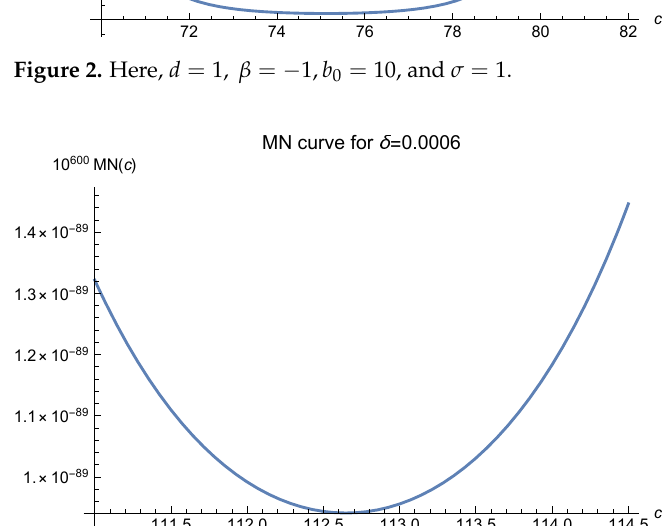
Figure 2. Here, d = 1, β = − 1, b 0 = 10, and σ = 1.